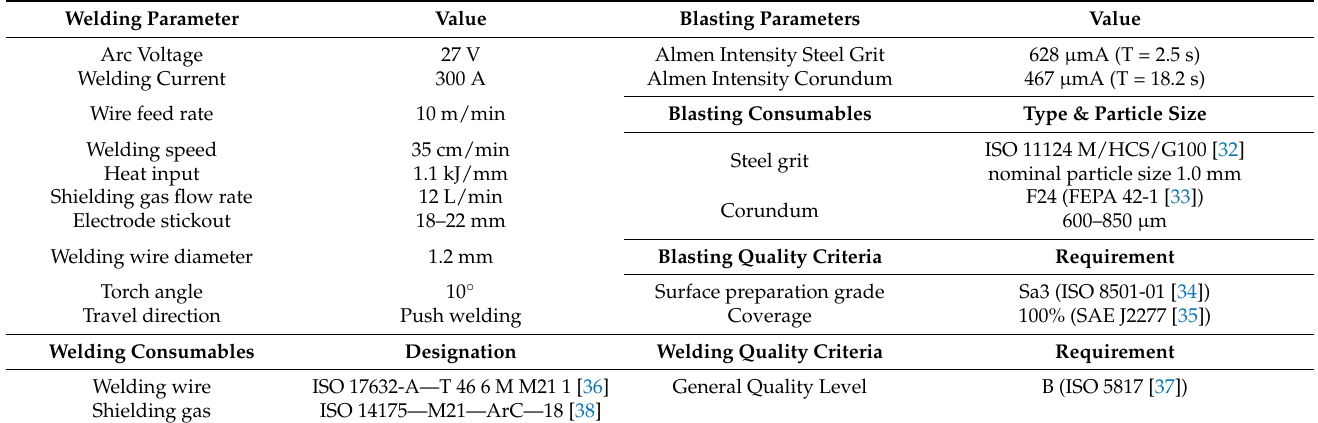
Table 1. Parameters, consumables and quality requirements for welding and blasting.